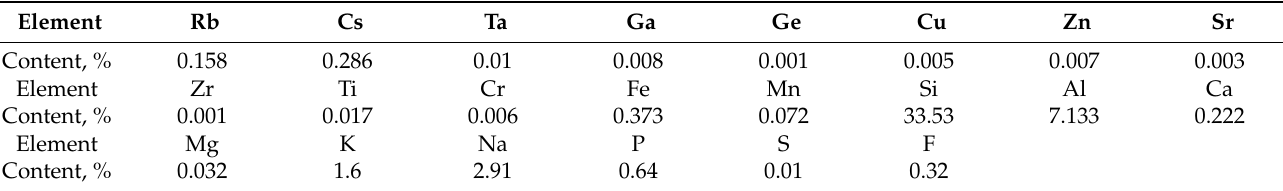
Table 2. Semi-quantitative analysis results of XRF.